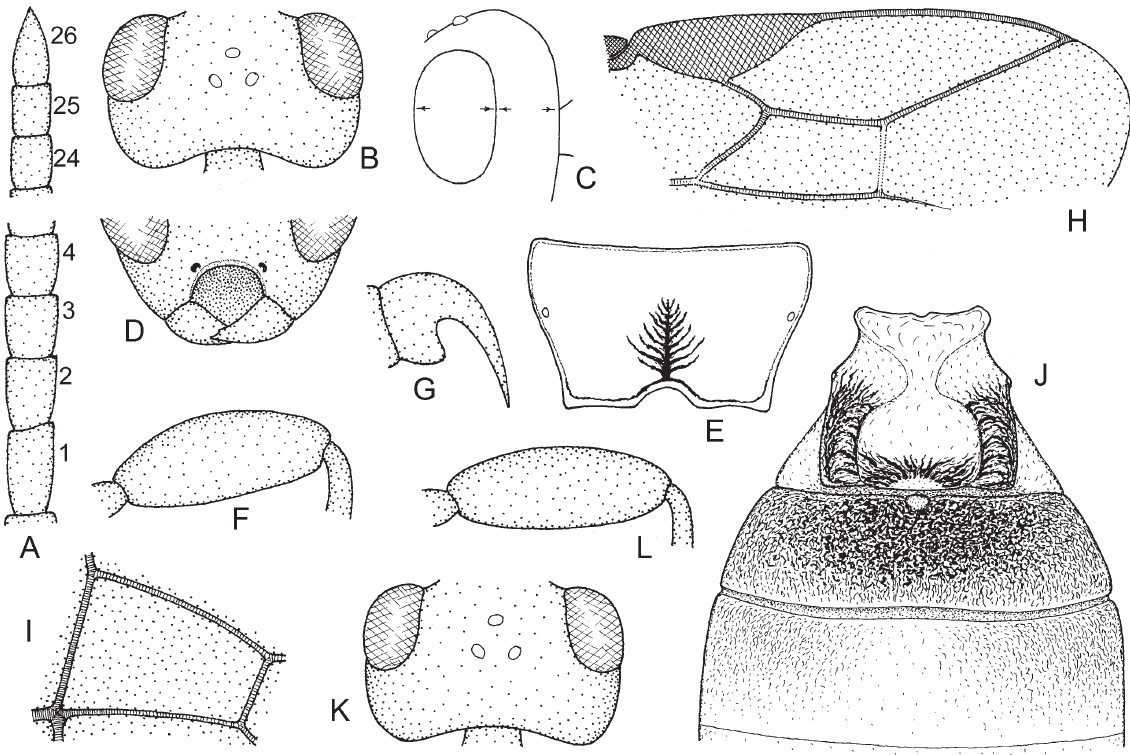
Fig. 8. Bracon ( Lucobracon ) erraticus Wesmael, 1838 (A-J: ♀ lectotype, K: ♀ paralectotype, L: ♀). A . Flagellomeres 1-5 and 24-26. B . Head in dorsal view. C . Head in lateral view. D . Head in frontal view. E . Propodeum. F . Hind femur. G . Claw. H . Distal part of right forewing. I . First discal cell of right forewing. J . Tergites 1-3. K . Head in dorsal view. L . Hind femur (of var . superciliosus Wesmael,